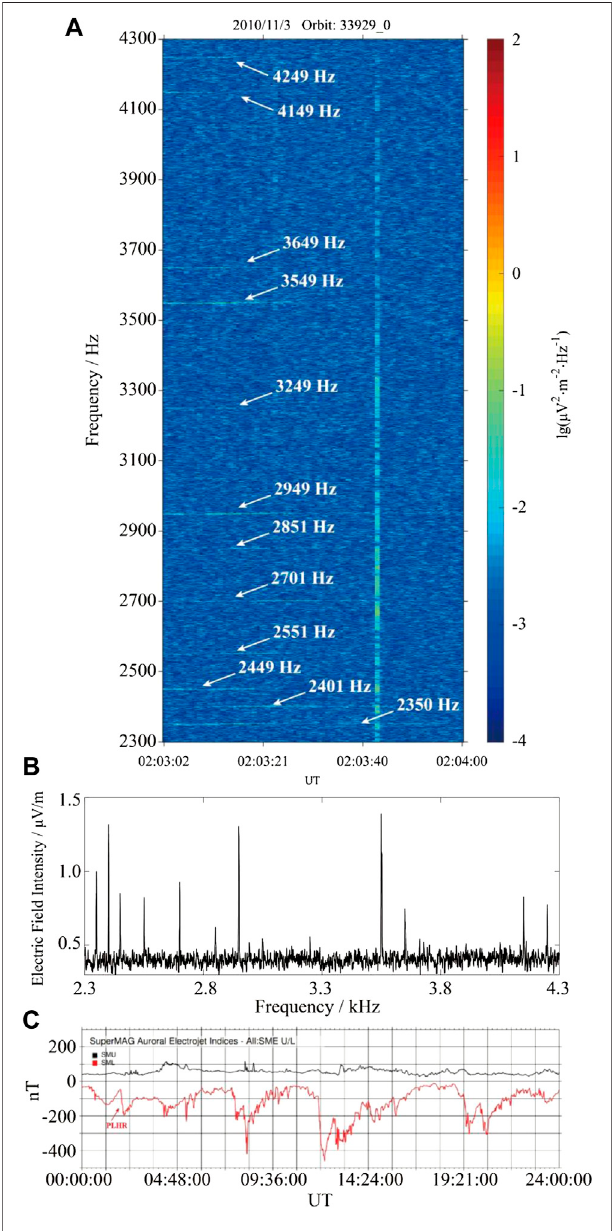
FIGURE6| UncommonPLHRoccurrencesoverthe±500 kVYiminAC- to-DC substation. (A) Time-frequency spectrogram of the electric fi eld intensity along orbit 33,929_0. (B) Amplitude-frequency characteristics of the electric fi eld intensity. (C) Fluctuation of the geomagnetic indices SMU/SML.